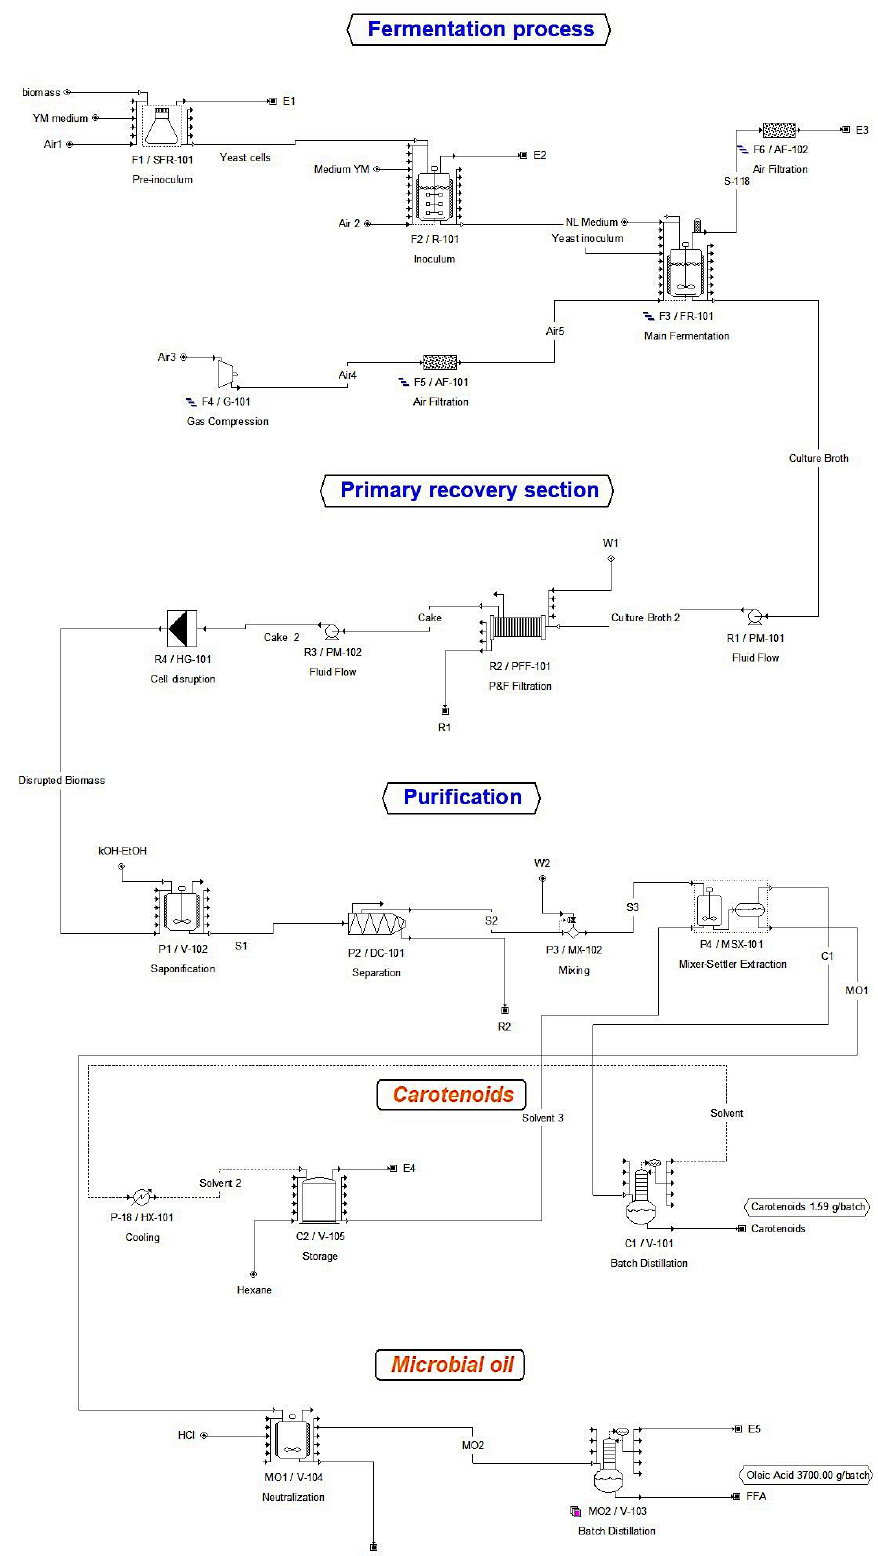
Figure 1. Flow diagram of the bioprocess for microbial oil and carotenoids production (SuperPro Designer ® ).